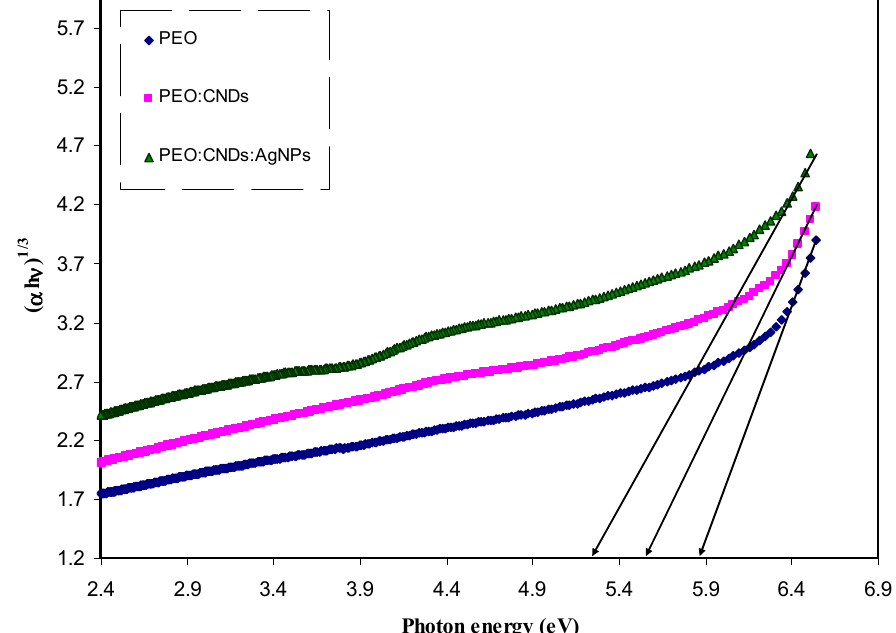
Figure 10. Plot of ( α h υ ) 2 / 3 vs. photon energy for pure PEO (PEPN0), PEO:CNDs (PEPN1), and PEO:CNDs:Ag (PEPN2) composite samples.